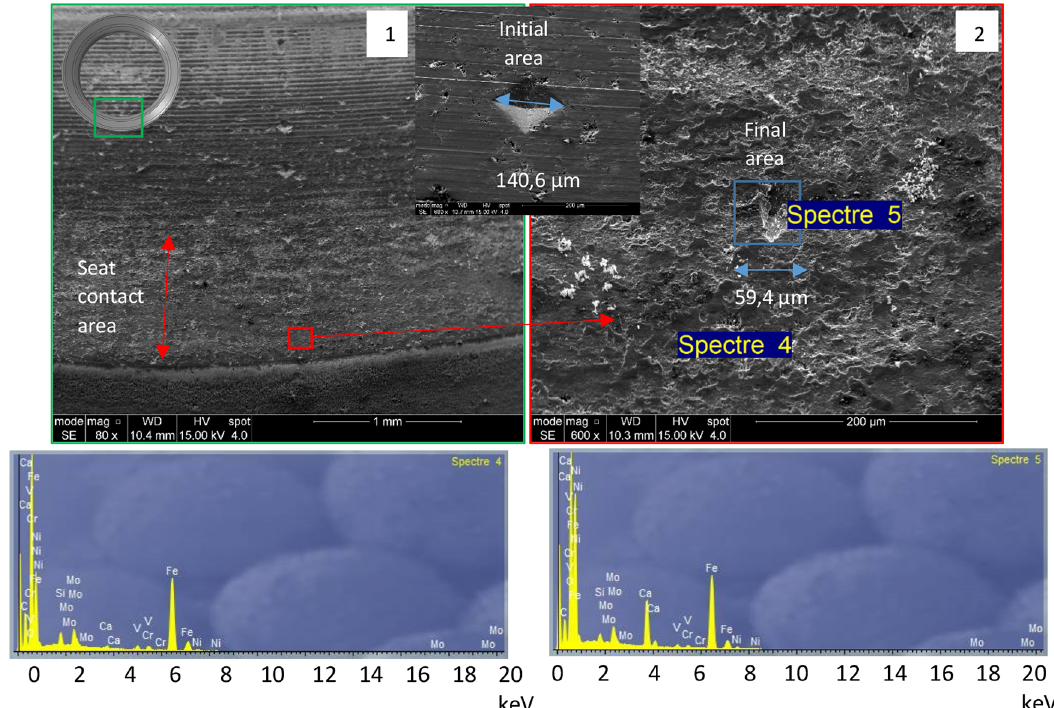
Fig. 18. Inlet seat after 2 hours of operation with fresh air inlet, heating to 250 ° C, 18.75N and impact speed of 650 mm/s, (1) general view of the contact, (2) magni fi cation in the effective contact area, Spectrum 4 and 5 elementary